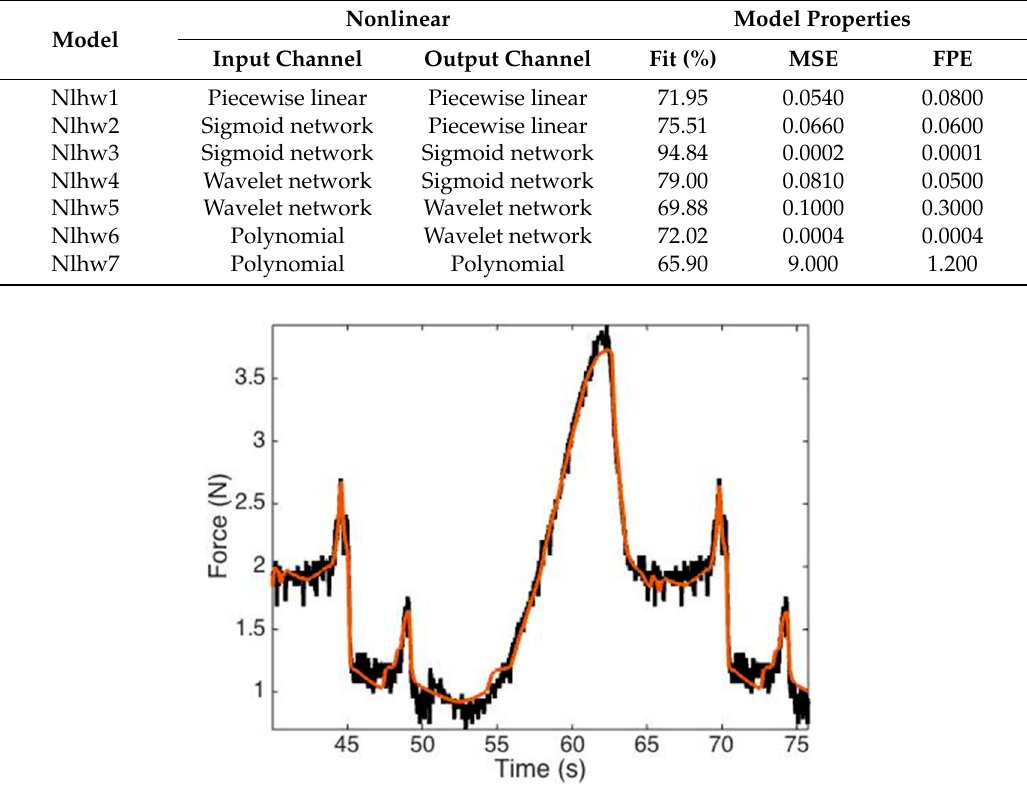
Figure 11. Nonlinear black-box H-W model simulations of the validation data. The orange and black traces represent the simulated and measured output force values, respectively.